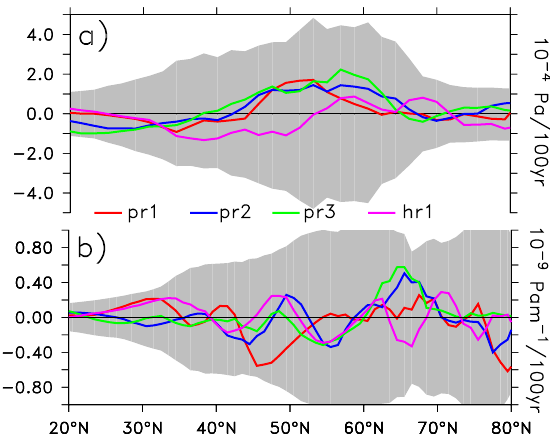
Figure 7. Simulated (experiments pr1, pr2, pr3, and hr1) 20th century linear trends (1905–2005) as zonal averages over the At- lantic basin of (a) zonal wind stress (units 10 − 4 Pa / 100years) and (b) wind stress curl (in 10 − 9 Pa / 100years). Coloured lines denote the experiments pr1, pr2, pr3, and hr1, and the grey-shaded regions bracketing the zero line show the 5th–95th-percentile range of cen- tennial trends in the unperturbed PiCtrl